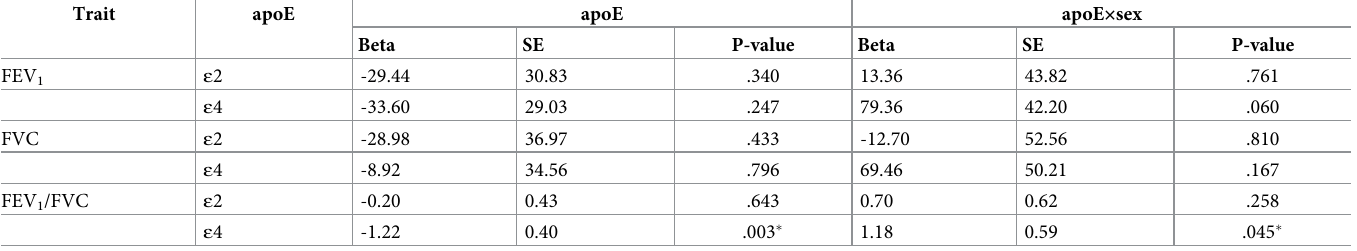
Table 5. Associations of the APOE ε 2 and ε 4 alleles with FEV 1 , FVC, and FEV 1 /FVC and their multiplicative interactions with sex in the genotyped LLFS participants.